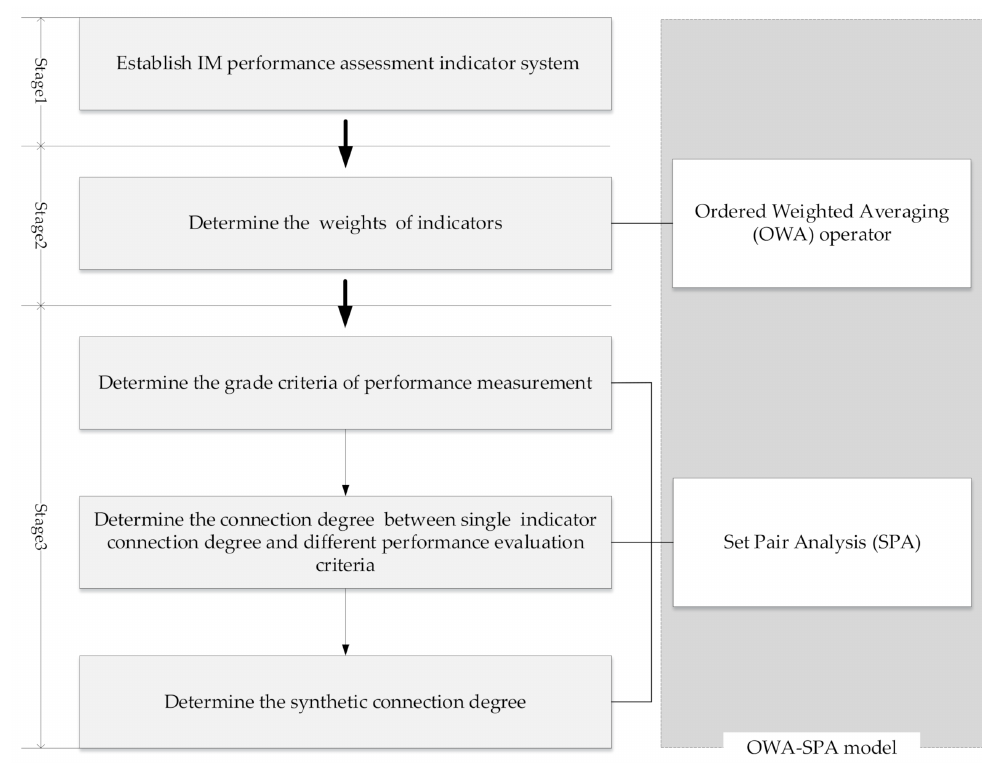
Figure 1. The research flow for model